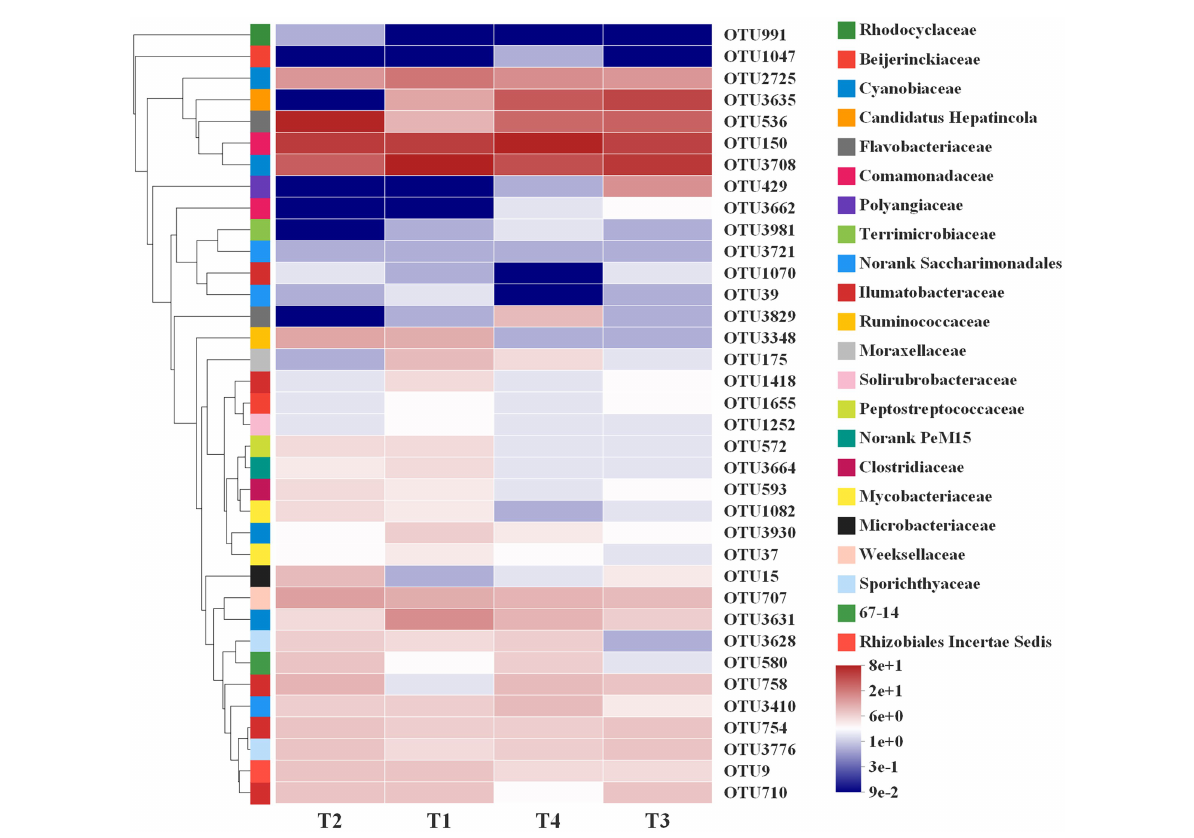
FIGURE 8 Relative abundance of the first 36 indicator bacteria in different growth stages (T1, T2, T3, and T4) in B. calyciflorus based on random forests regression model. The abscissa is the group name, and the ordinate is the species name. The abundance changes of different species in the sample are displayed through the color gradient of color blocks. On the right side of the figure, the lower side is the value represented by the color gradient, and the upper color level represents the family to which OUT